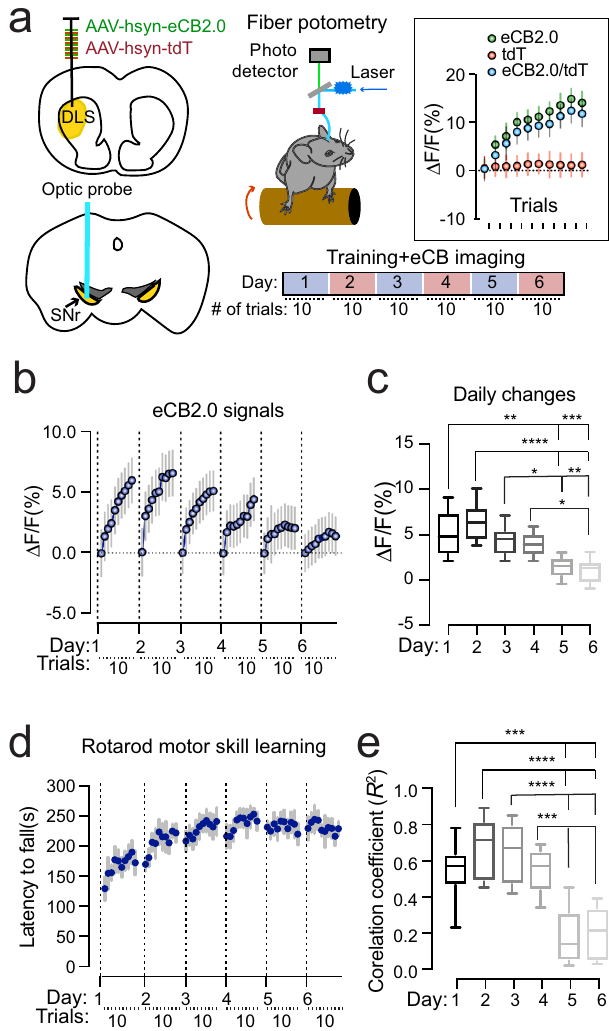
Fig. 4 DAGLB-mediated 2-AG biosynthesis in the nigral DANs is involved in locomotor skill learning. a Schematic diagram of eCB2.0 fi ber photometry recoding while mice undergo rotarod locomotor skill training. Inset shows the average eCB2.0 (green), tdT (red), and normalized eCB2.0 (blue) signals during each trial from one representative mouse on day 2 of the 6-day training paradigm ( n = 1). Data were presented as mean ± SD. b Normalized eCB2.0 signal intensity during the locomotor learning. n = 8 (4M/4F). Data were presented as mean ± SD. c Box and whiskers plot (the minimum, the 25th percentile, the median, the 75th percentile, and the maximum) of maximal daily increase of eCB2.0 signal intensity. n = 8 (4M/ 4F). Tukey ’ s multiple comparisons adjusted, * p = 0.02, ** p = 0.001, *** p = 0.0003, **** p < 0.0001. d Performance of rotarod motor skill training. n = 8 (4M/4F). Data were presented as mean ± SEM. e Box and whiskers plot (the minimum, the 25th percentile, the median, the 75th percentile, and the maximum) of correlation coef fi cient of eCB2.0 signal intensity and rotarod performance. n = 8 (4M/4F). Tukey ’ s multiple comparisons adjusted, *** p = 0.0002 to 0.0006, **** p < 0.0001. 4-month-old Daglb KO mice displayed modest but statistically insigni fi cant improvement of locomotor learning [two-way ANOVA, genotype: F (1, 19) = 2.9, p = 0.103] (Supplementary